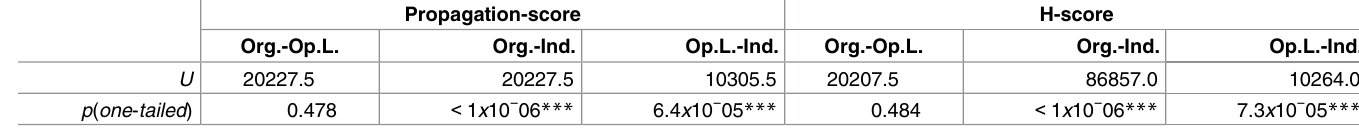
Table 2. Comparison of influential values in breadth ( propagation-score ), and depth ( hop-score ). Results from Mann-Whitney U Test (H2).